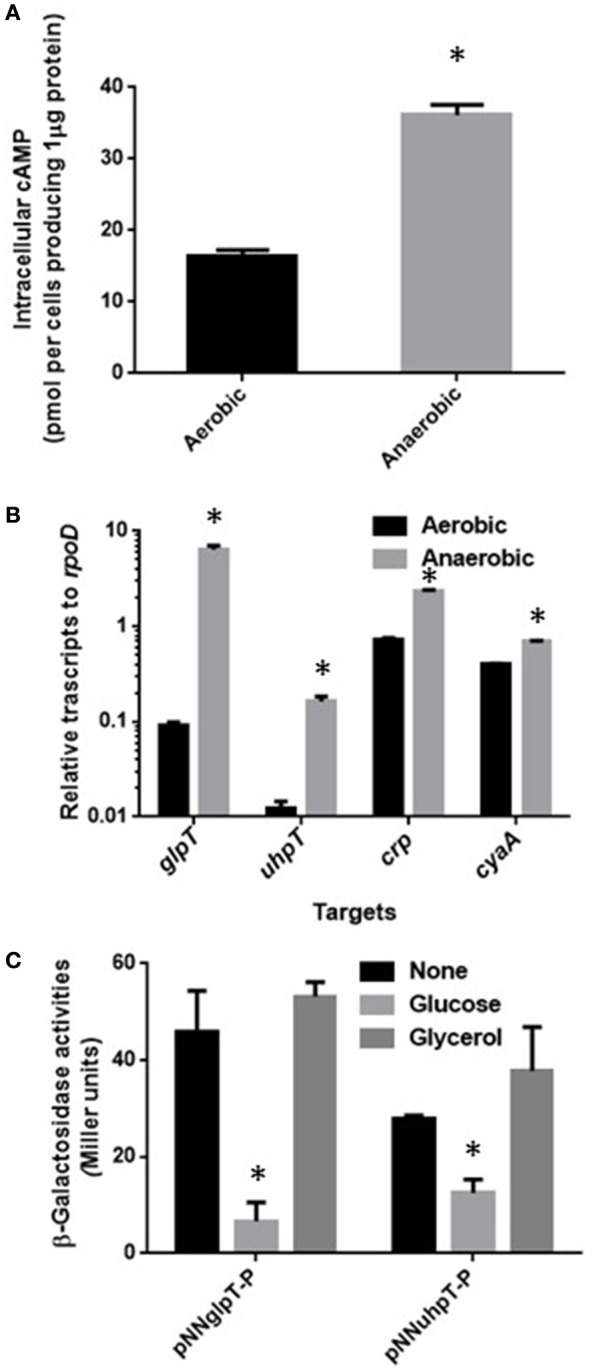
Activity of CRP-cAMP in the wild-type parent grown under aerobic or anaerobic conditions. Intracellular concentration of cAMP (A) and transcript levels of crp and cyaA together with glpT and uhpT
(B) in the wild-type parent grown under aerobic or anaerobic conditions were compared. Intracellular concentration of cAMP is given as the amount of cAMP were represented as pmol per cells producing one μg of protein. Transcript levels of crp, cyaA, glpT, and uhpT were described as relative values to that of rpoD (housekeeping gene). Data plotted are the means of two biological replicates, error bars indicate the ranges, *P < 0.01. Asterisks denote significance for values of intracellular cAMP or mRNA level in bacterial cultures under anaerobic conditions relative to those under aerobic conditions. (C) β-Galactosidase activities from lacZ expression in the wild-type parent correspond to glpT or uhpT promoter activities were measured when grown with or without glucose under aerobic and anaerobic conditions. Data plotted are the means from three independent experiments; error bars indicate the standard deviations, *P < 0.01. Asterisks denote significance for values of β-galactosidase activity in the wild-type parent grown with glucose relative to those in the wild-type parent grown without glucose.